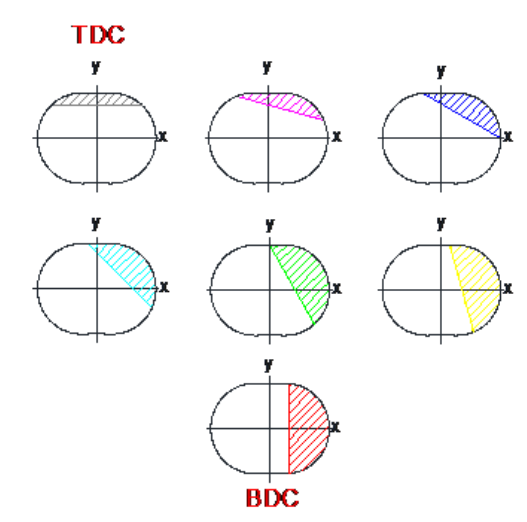
Fig. 3: Szorenyi engine chamber cross-sectional area at 0, 30, 60 and 90 degrees of the crankshaft angle.